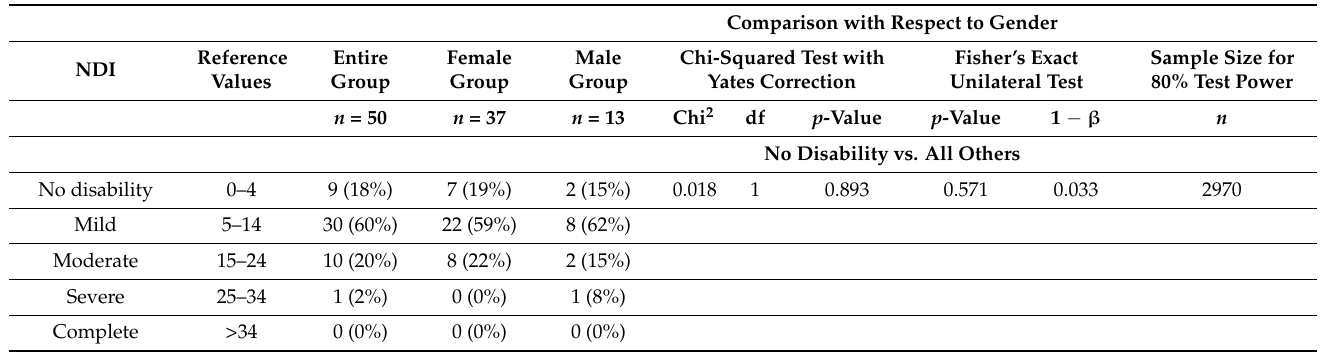
Table 5. Neck disability with respect to the NDI. Numerical and percentage values are given for the study group ( n = 50) and for the group of females ( n = 37) and males ( n = 13). Comparison with Respect to